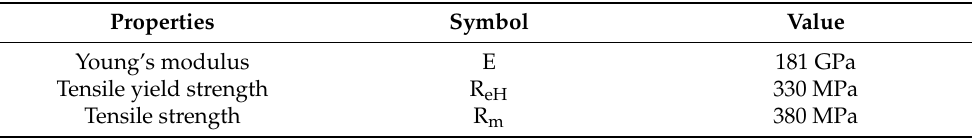
Table 1. Strength properties of DX51.